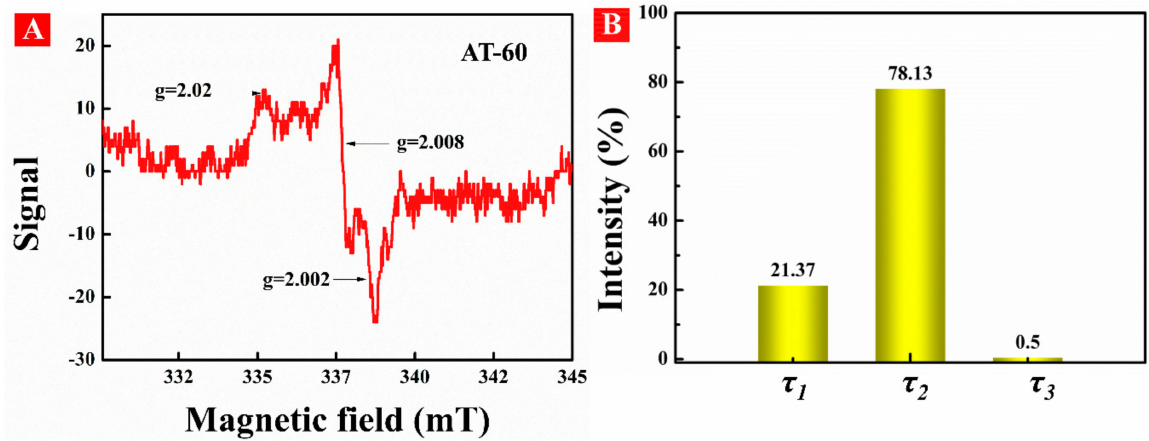
Figure 4. ( A ) EPR spectra and ( B ) positron lifetime and relative intensities of AT-60